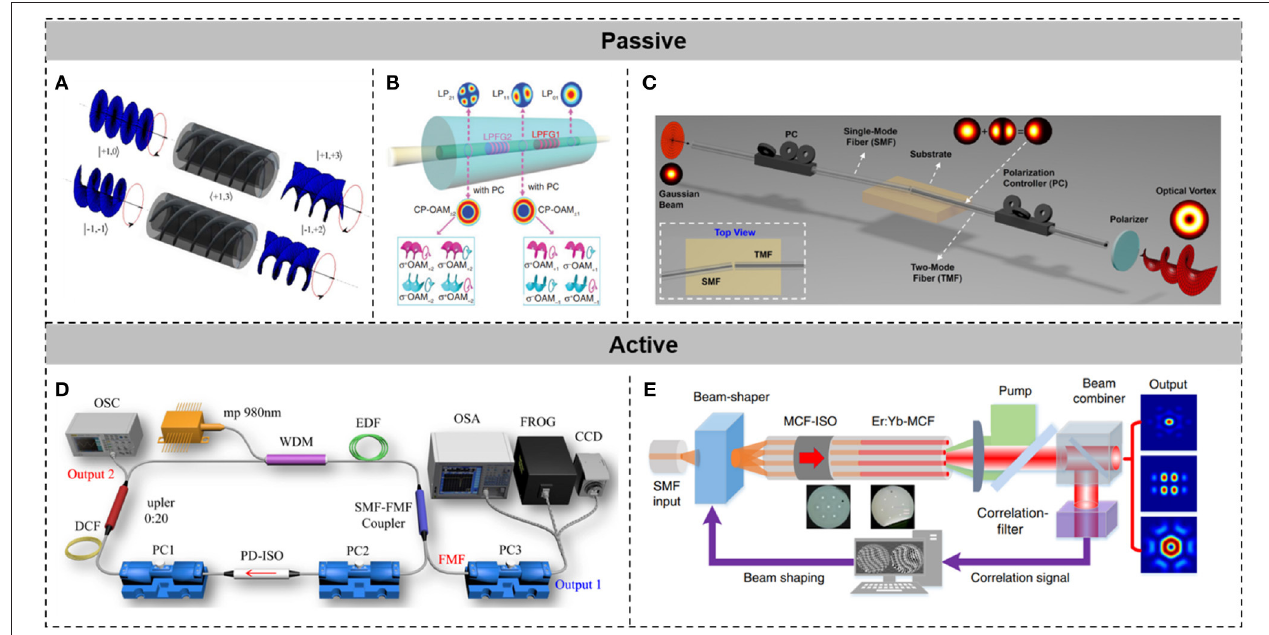
FIGURE 4 | Generation of spatial-structured light beams, utilizing fiber-based devices. (A) A helical fiber grating for generating optical vortex beams. Reprinted from Fang and Wang [ 48]. (B) Generating optical vortex beams, using long-period fiber gratings. Reprinted from Han et al. [49]. (C) Fiber-to-fiber butt coupling for generating optical vortex beams. Reprinted from Li et al. [50]. (D) A schematic of an optical vortex laser, using a mode selective coupler. Reprinted from Wang et al. [ 51]. (E) A reconfigurable multicore fiber laser for generating optical vortex beams and vector beams. Reprinted from Lin et al.